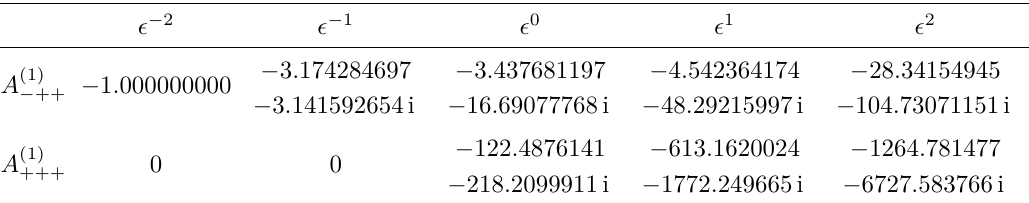
Table 4. Reference evaluations of all independent bare one-loop amplitudes on the phase-space point of eq. (3.12).